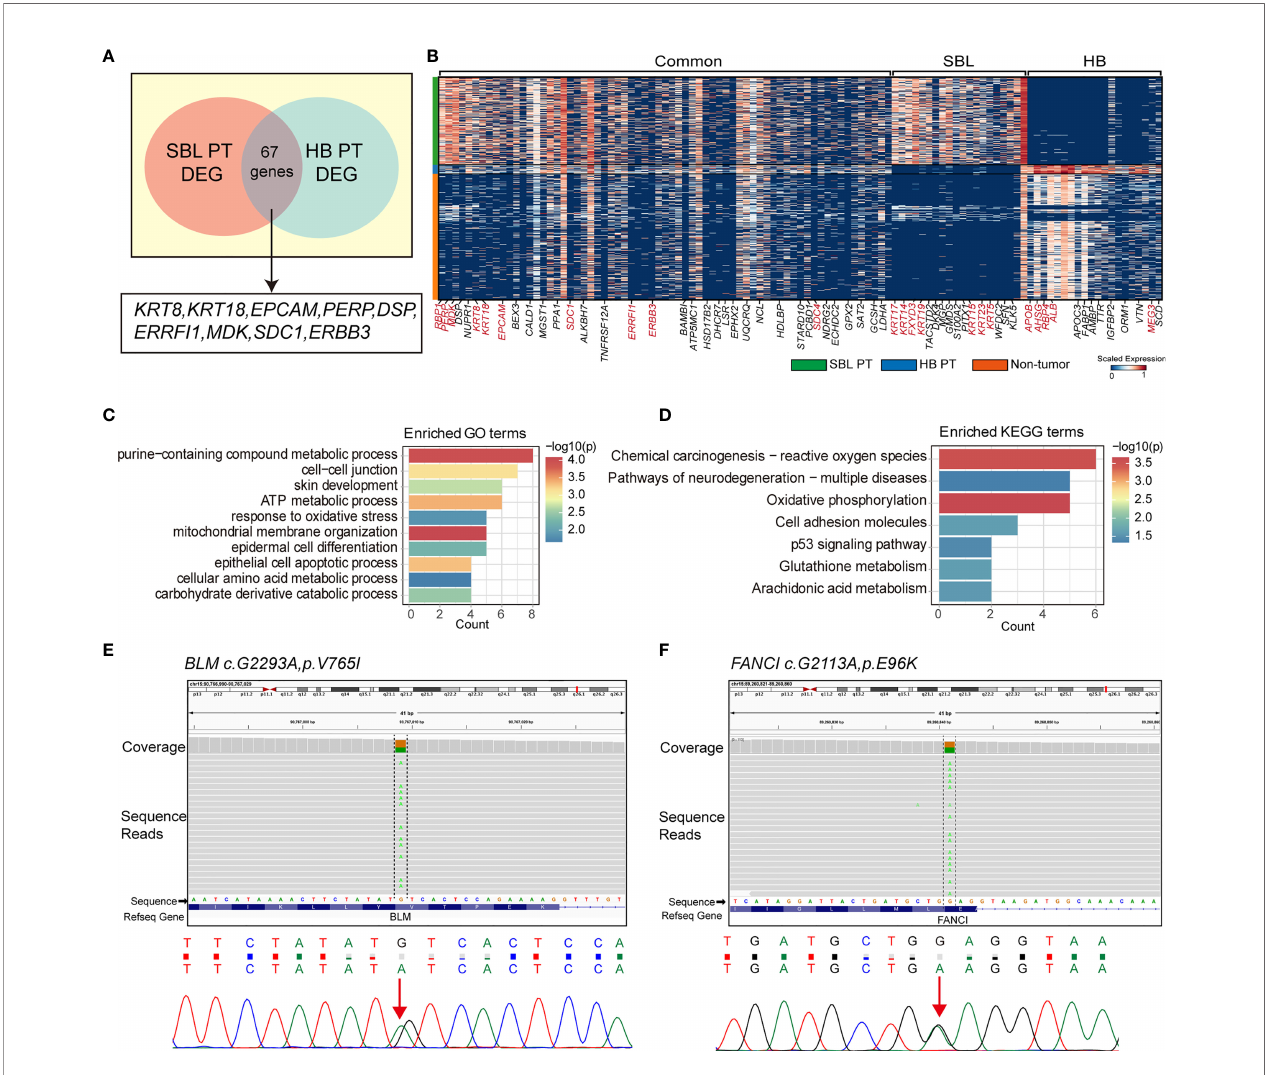
FIGURE 6 | Transcriptional similarities between SBL and HB malignant cells. (A) Venn diagram displaying shared signature genes between SBL and HB malignant cells. (B) Heatmap showing the expression of shared genes and selected top20 unique signature genes in SBL and HB malignant cells. (C) Bar chart showing the enrichment of GO terms, based on shared signature genes between SBL and HB malignant cells. (D) Bar chart showing the enrichment of KEGG terms, based on shared signature genes between SBL and HB malignant cells. (E) IGV screenshot (upper) and DNA sequence chromatogram of Sanger sequencing (bottom) demonstrating BLM c.G2293A, pV765I germline mutation. (F) IGV screenshot (upper) and DNA sequence chromatogram of Sanger sequencing (bottom) demonstrating FANCI c.G2113A, pE96K germline mutation. SBL, sialoblastoma; HB, hepatoblastoma; PT, primary tumor; DEG, differentially expressed